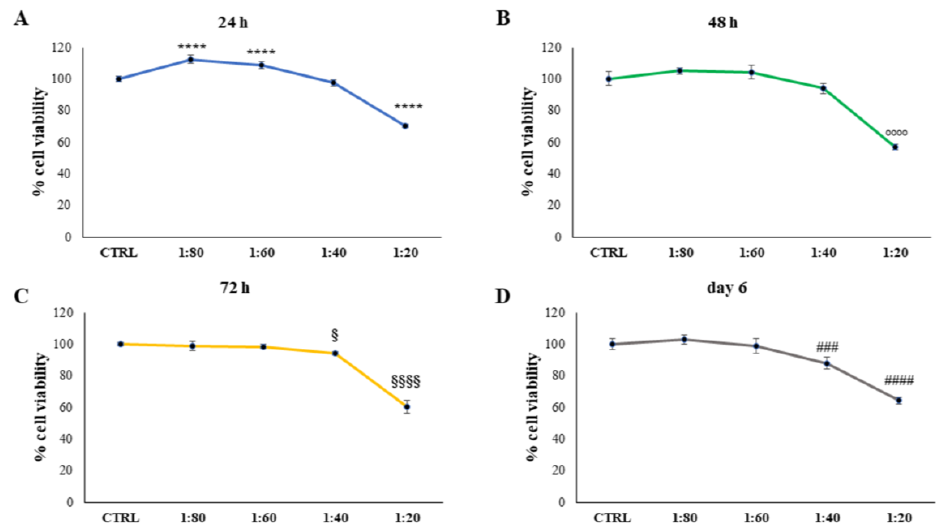
Figure 1. 3-(4,5-dimethylthiazol-2-yl)-2,5-diphenyltetrazolium bromide (MTT) assay performed on HaCat cells treated for 24 h ( A ), 48 h ( B ), 72 h ( C ), and 6 days ( D ) with snail slime (SS) diluted to 1:80, 1:60, 1:40, and 1:20 within the culture medium. Metabolic activity was normalized to control cells treated with Dulbecco ’ s Modified Eagle Medium (DMEM). The most representative of three separate experiments is shown. Data are presented as the mean ± standard deviation. **** vs. control sample (CTRL) 24 h p < 0.0001; °°°° vs. CTRL 48 h p < 0.0001; §§§§ vs. CTRL 72 h p < 0.0001; § vs. CTRL 72 h p = 0.0127; #### vs. CTRL day 6 p < 0.0001; ### vs. CTRL day 6 p = 0.007. SS was administered at 1:20 and an appreciable and significant increase in viable cells was detected after treatment with 1:60 and 1:80 dilutions, compared with the control (CTRL1). After 48 h of treatment, again, the SS dilution of 1:20 led to a statistically signif- icant reduction in cell viability compared with the control. After 72 h and 6 days, SS dilu- tions of 1:20 and 1:40 provoked a significant decrease in cell viability, with a major extent for dilution 1:20. 2.2. Analysis of Macrophage Viability and Activation Human macrophages were firstly exposed to decreasing concentrations of SS (1:20, 1:40, 1:60, and 1:80) to evaluate its biocompatibility and the activation rate on immune cells as very sensitive ones (Figure 2A).